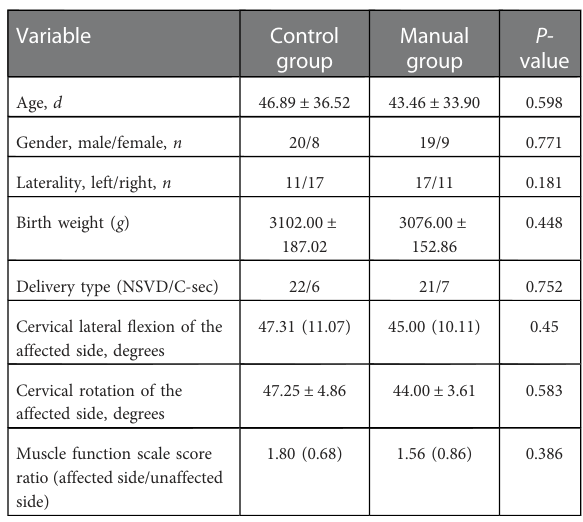
TABLE 1 The baseline of all infants with